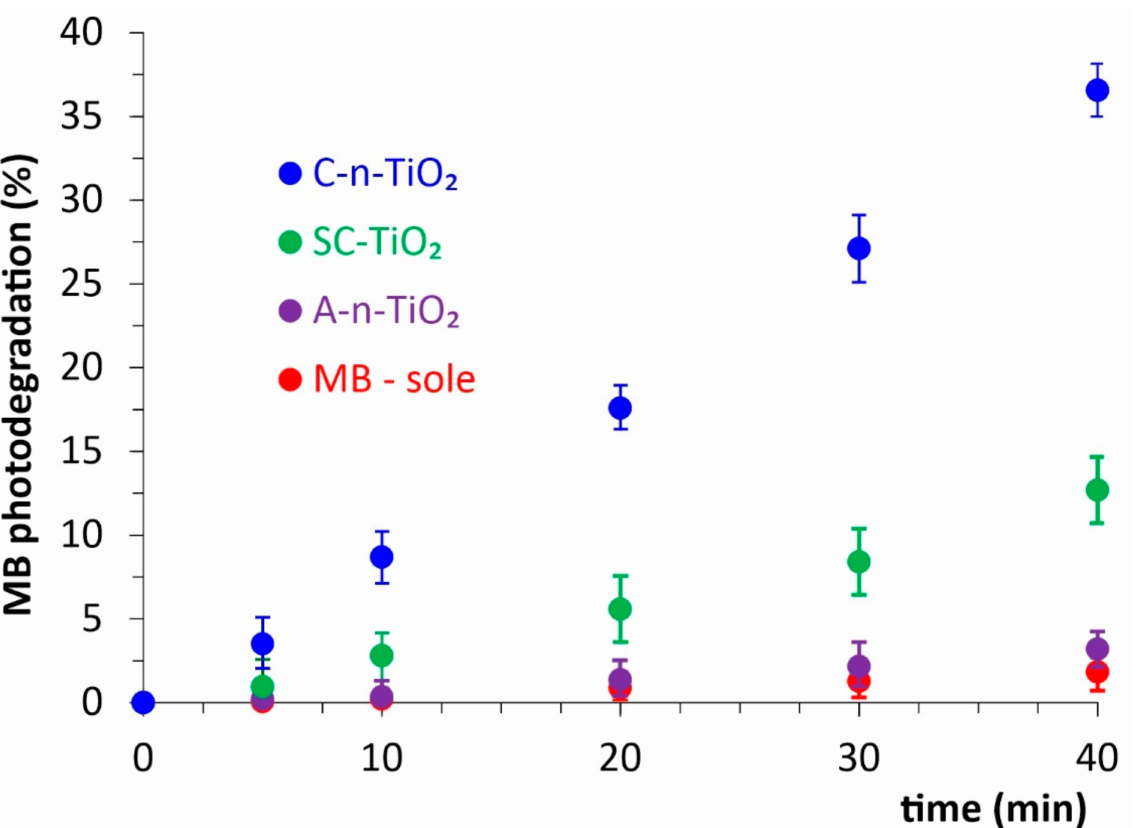
Figure 3. The photocatalytic properties of synthesized n-TiO 2 during Methylene Blue (MB) degrada- tion.